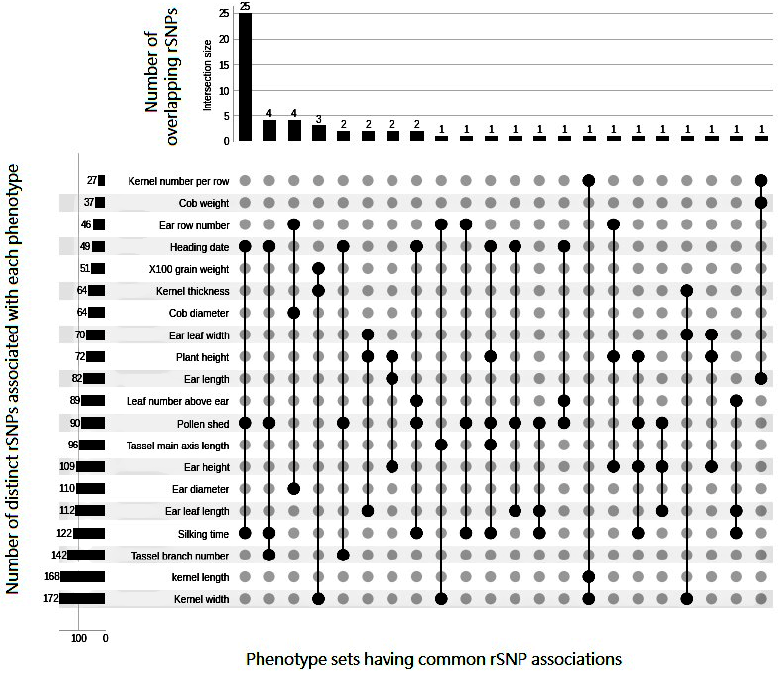
Figure 3. Number of associated rSNPs determined by the incremental feature selection (IFS) pro- cedure for each phenotype and their overlap represented in matrix layouts using the UpSet tech- nique [67]. Black circles in the matrix layout are related to the phenotypes that are part of the intersection. For the sake of clarity, not all intersections are